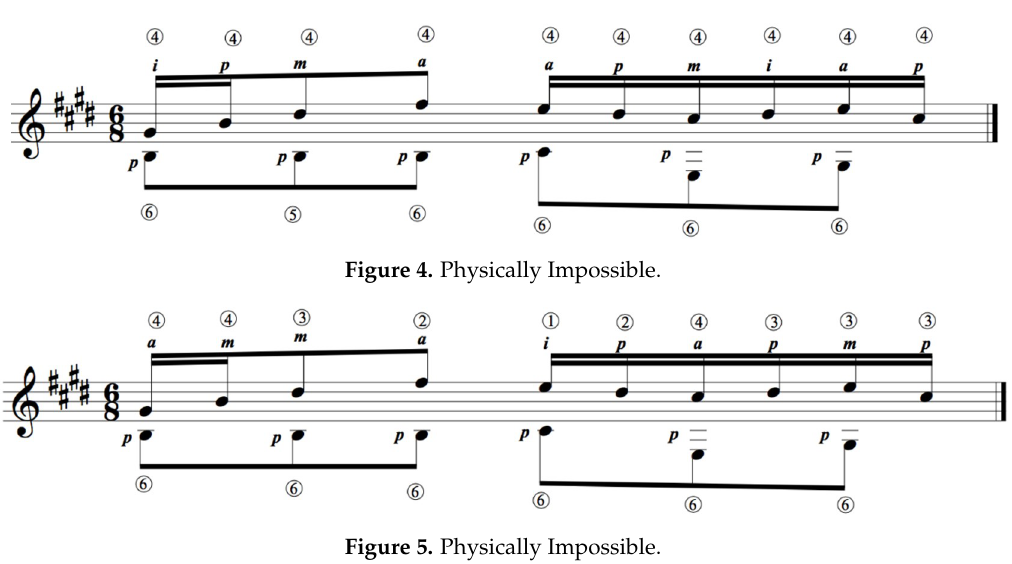
Figure 3. Physically Impossible.